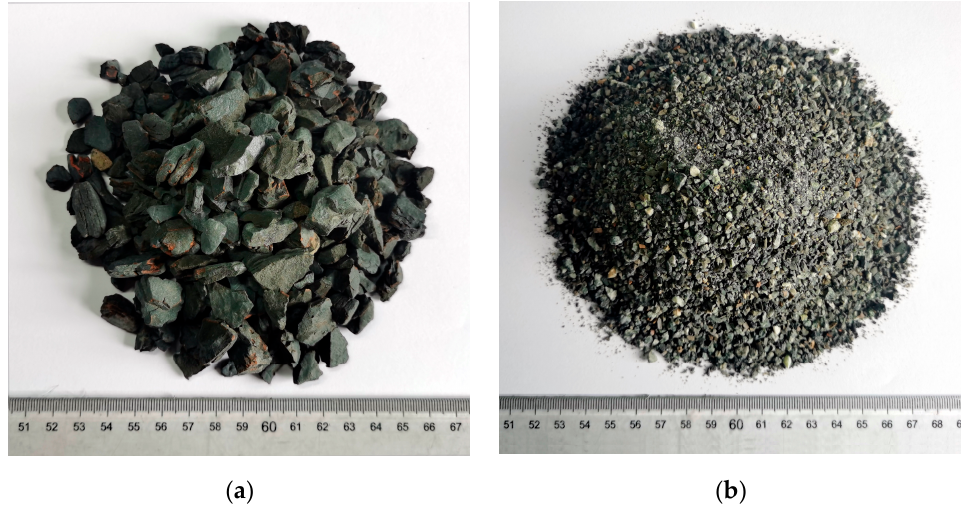
Figure 1. The images of aggregates: ( a ) SC; ( b ) SPS.